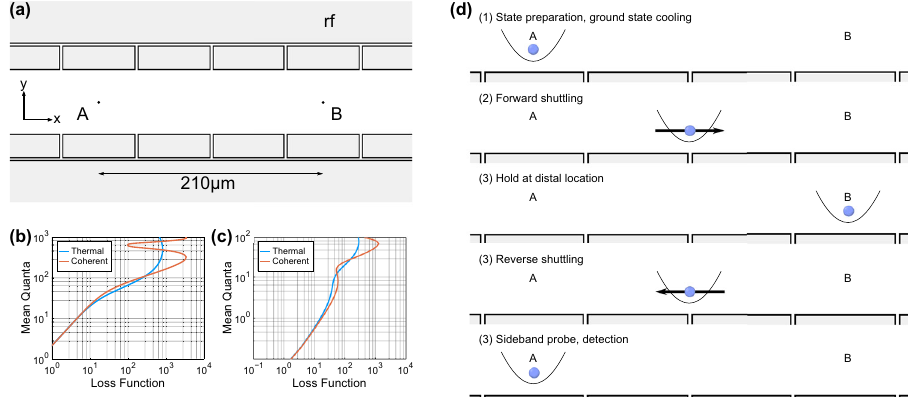
Fig. 1 Geometry of the system and loss function. a An ion is trapped at location A where it is prepared in the axial ( ^ x ) ground state of motion (cid:1) (cid:3) (cid:1) . It is then shuttled to B in 6 μ s and held there for at least 12 μ s before being shuttled back. The drawing and in the electronic state S 1 = 2 ; (cid:2) 1 2 shows the rf rails and interior control electrodes (but not the outer control rails). The relationship of the loss function to the mean quanta for both thermal and coherent motion is shown in ( b ) and ( c ) using experimentally relevant probe times. Probe time t m corresponds to the m -th order red sideband; b shows the relationship for ( t 1 , t 2 ) = (3 μ s, 10 μ s) and c shows the relationship for (25 μ s, 45 μ s). d A cartoon of the experimental transport sequence. The ion is prepared at A, then shuttled to location B and held there for a variable hold time before returning to A for a probe on the sidebands and detection.